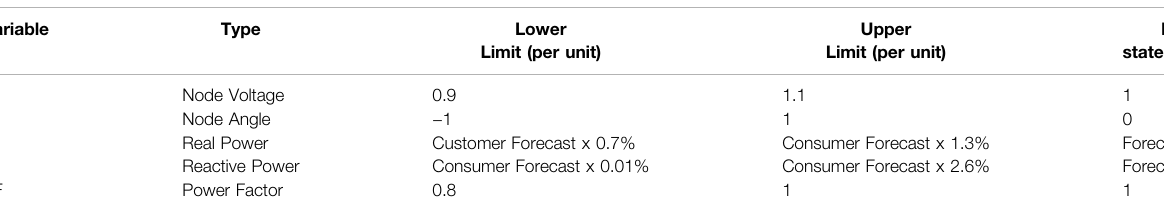
TABLE 2 | Optimization limits and data.